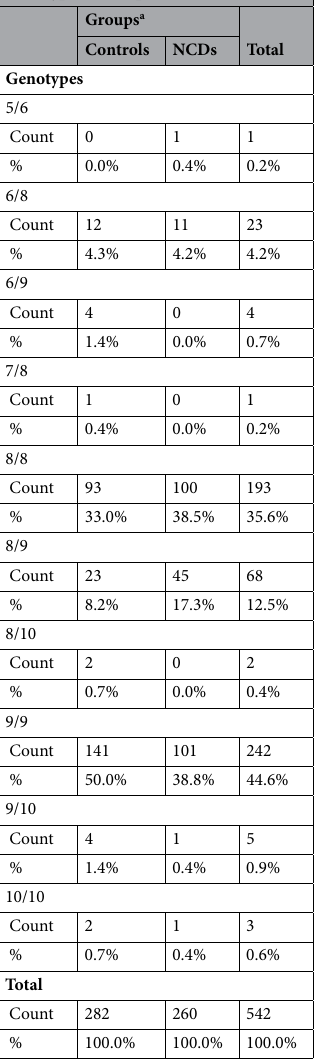
Table 2. Genotype distribution of the human SBF1 (GCC) repeat in the NCD and control groups. a Fisher’s exact p = 0.001. Counts and % represent within each